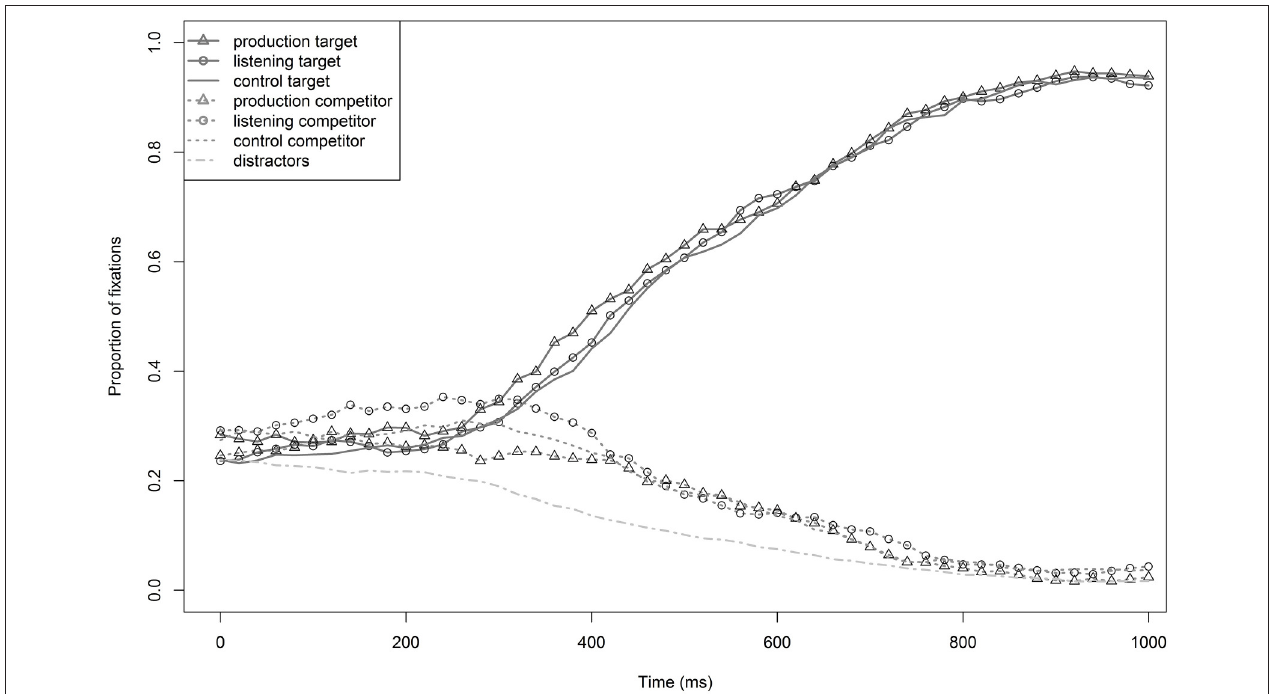
FIGURE 3 | Proportions of target ( PALME ) and competitor ( BALKEN ) fixations of the production, listening, and control groups in Experiment 2. The bottom line describes the mean number of distractor fixations of all three